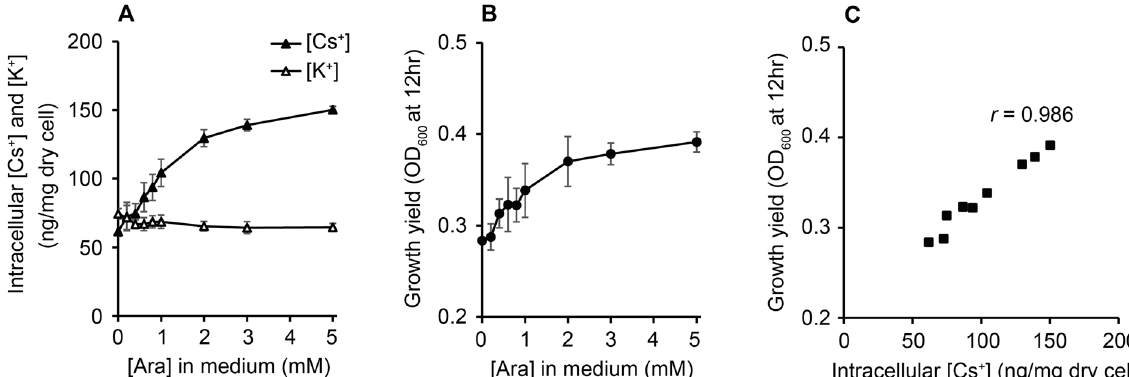
Figure 4. The effects of the induction of kup expression by arabinose supplementation on the growth stimulation of Cs + . The intracellular Cs + and K + concentrations ( A ) and the growth yields ( B ) were measured after 12 hr cultivation of the E. coli kup -IE strain in the K + -deficient medium supplemented with 1 mM of CsCl. ( C ) The growth yields were plotted against corresponding intracellular Cs + concentrations. Data are presented as means of three independent cultures, and error bars represent standard